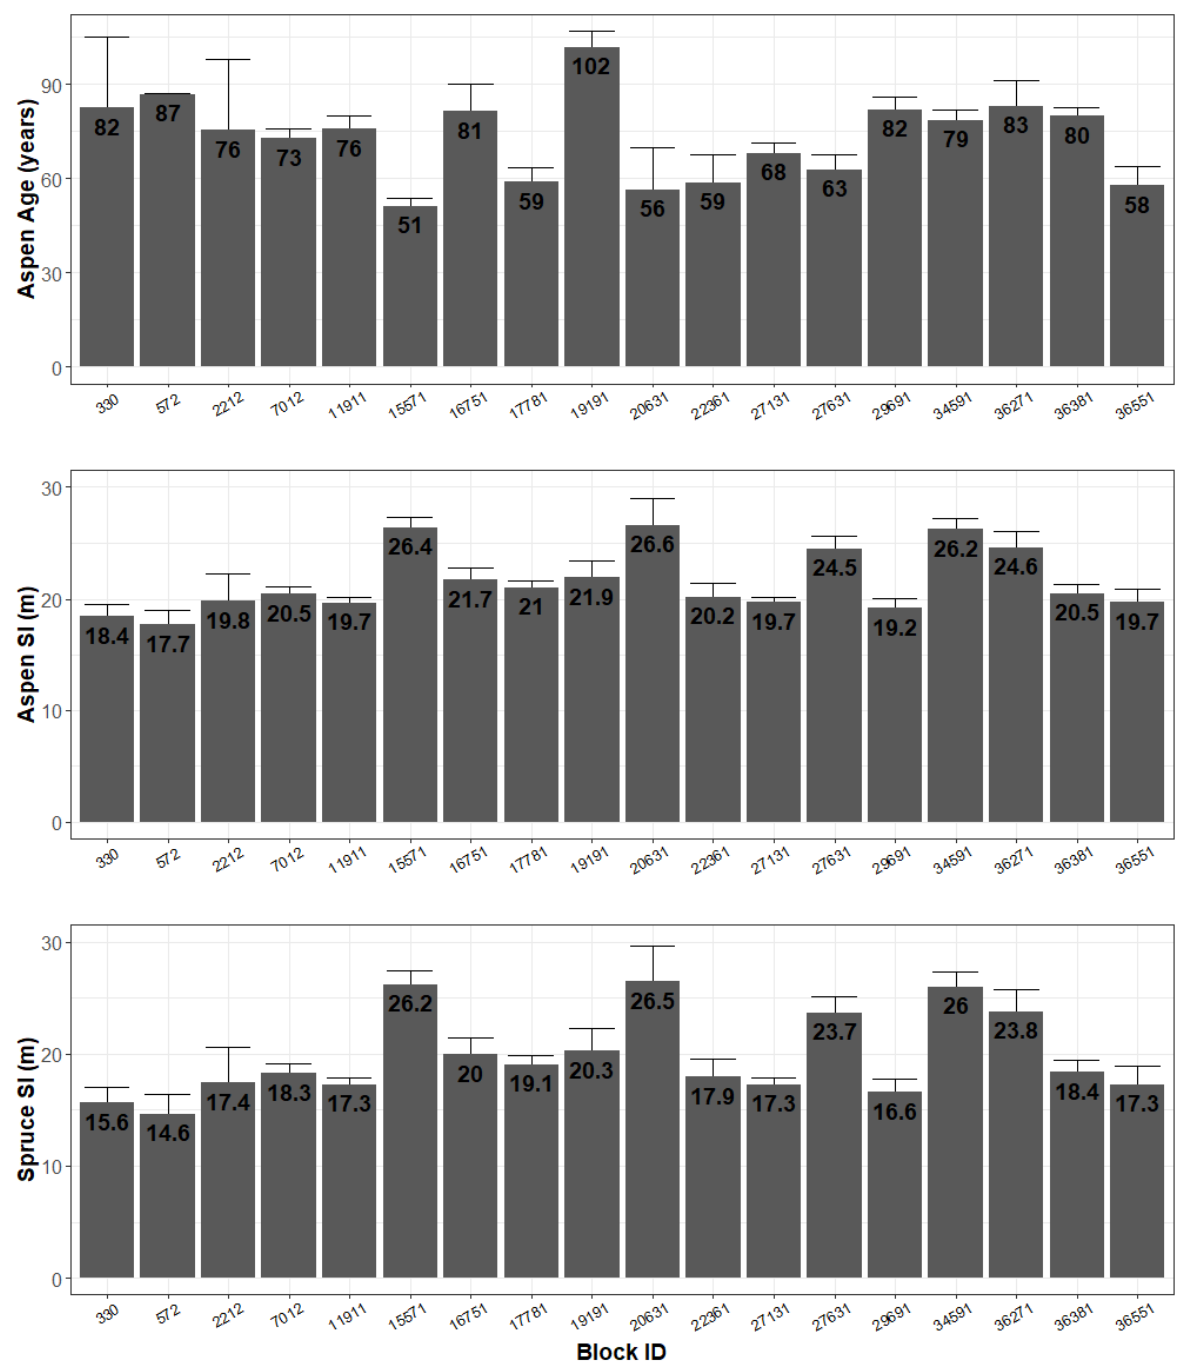
Figure 3. Mean aspen age and aspen and spruce site index for each sampled SCUP block. Total age and SI at a reference age of 50 years total age are presented. Numbers show mean; error bars show standard error of the mean.